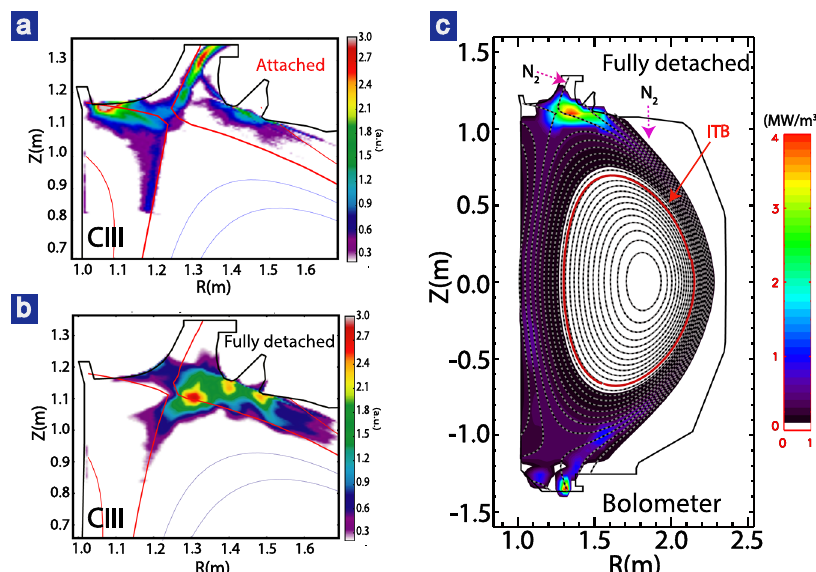
Fig. 3 2D radiation measured by bolometer (right) and CIII radiation from Tangential TV (left). Here, a.u. means arbitrary units. Both show the radiation peaks near the X-point during full detachment ( b , c ) with respect to the attachment ( a ) whose radiation peaks almost at the divertor plates. Note that the reconstructed bolometer radiation near the lower divertor target has a large uncertainty since several lower bolometer chords are cut-off by the shelf tiles. N 2 puf fi ng locations are shown as the purple